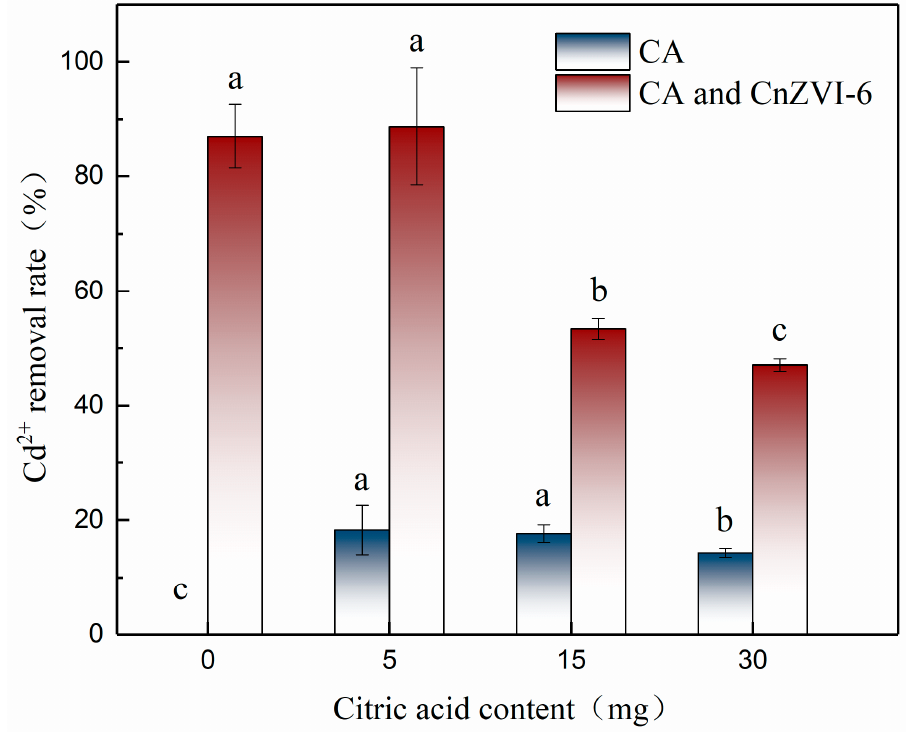
Figure 1. The removal efficiency of Cd(II) by CA with different concentrations (0, 5, 15, 30 mg) in the presence or absence of 15 mg CnZVI-6, respectively, in the solution (mean ± SE, n = 3). Different letters indicate significant differences among the CA groups with or without CnZVI-6 treatment at the p < 0.05 level according to Tukey test.